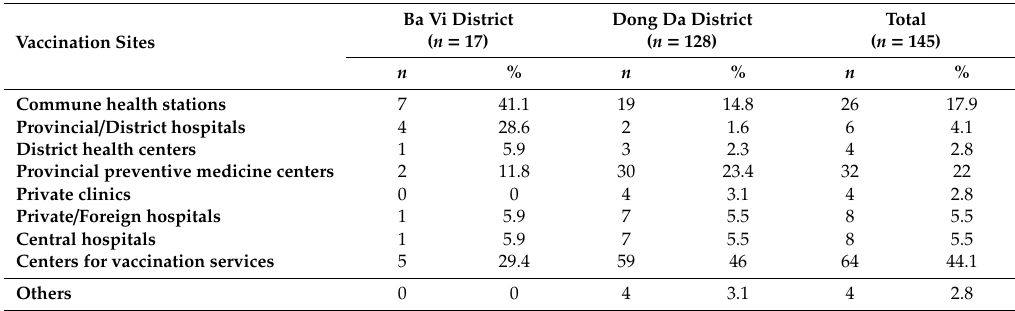
Table 2. Utilization of vaccination sites.